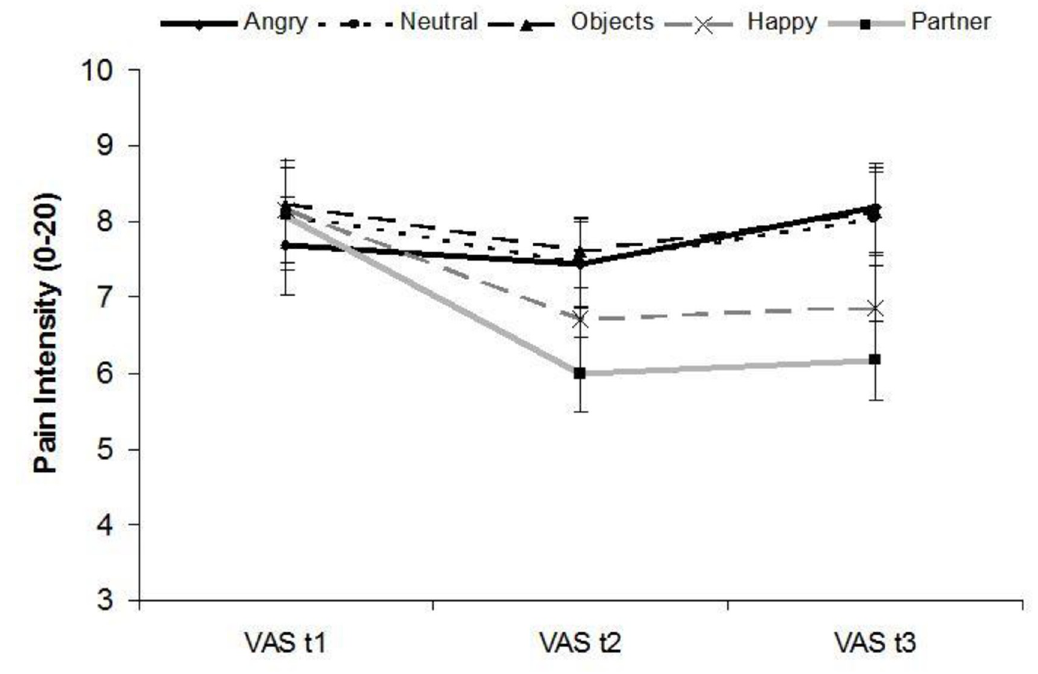
Fig 2. Pain intensity ratings during tonic heat pain stimulation. Ratings on a visual analogue scale (VAS; M, SE) before picture viewing (VAS t1), after picture viewing time (PVT) 1 (VAS t2) and after PVT 2 (VAS t3).